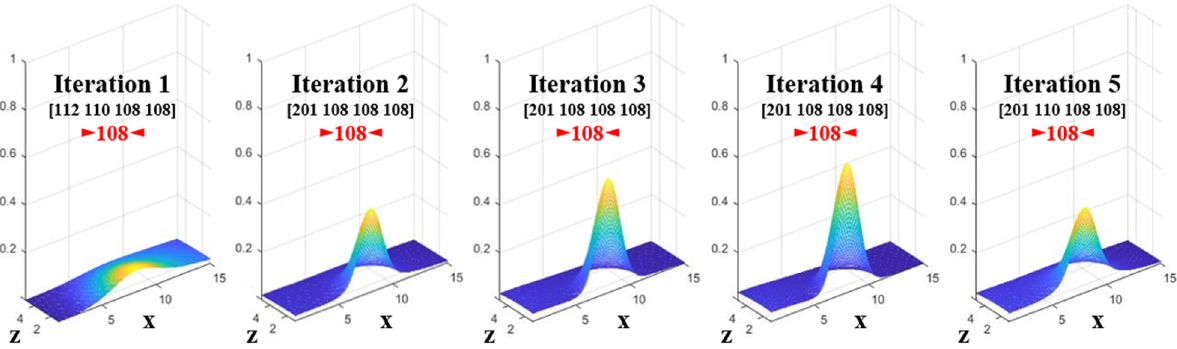
Figure 15. Probability functions for the initial five iterations of the case HS108HA030_SS04WA045 .